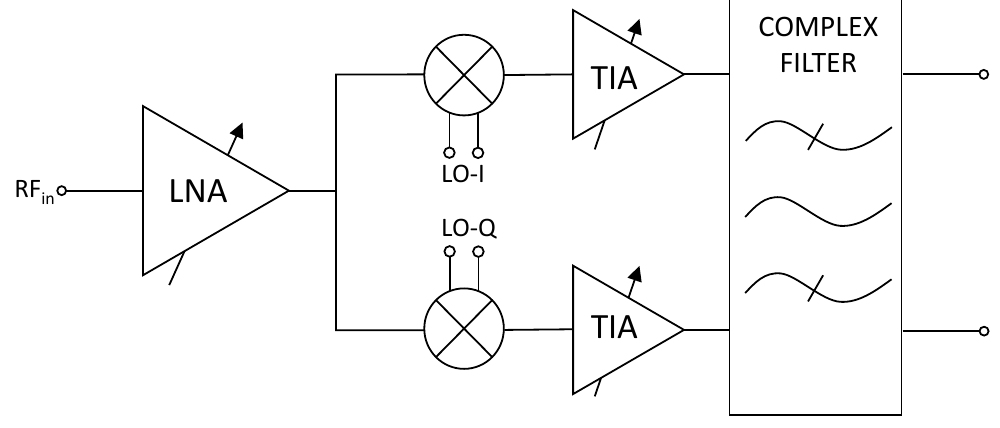
Figure 1. Architecture of a typical low-IF